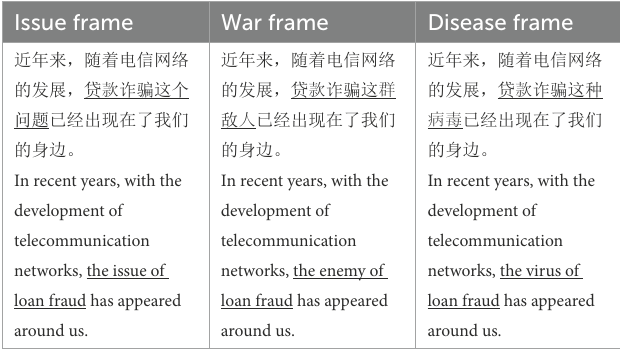
TABLE 2 Illustrative language manipulations with translations in Experiment 2 (Differences across conditions are